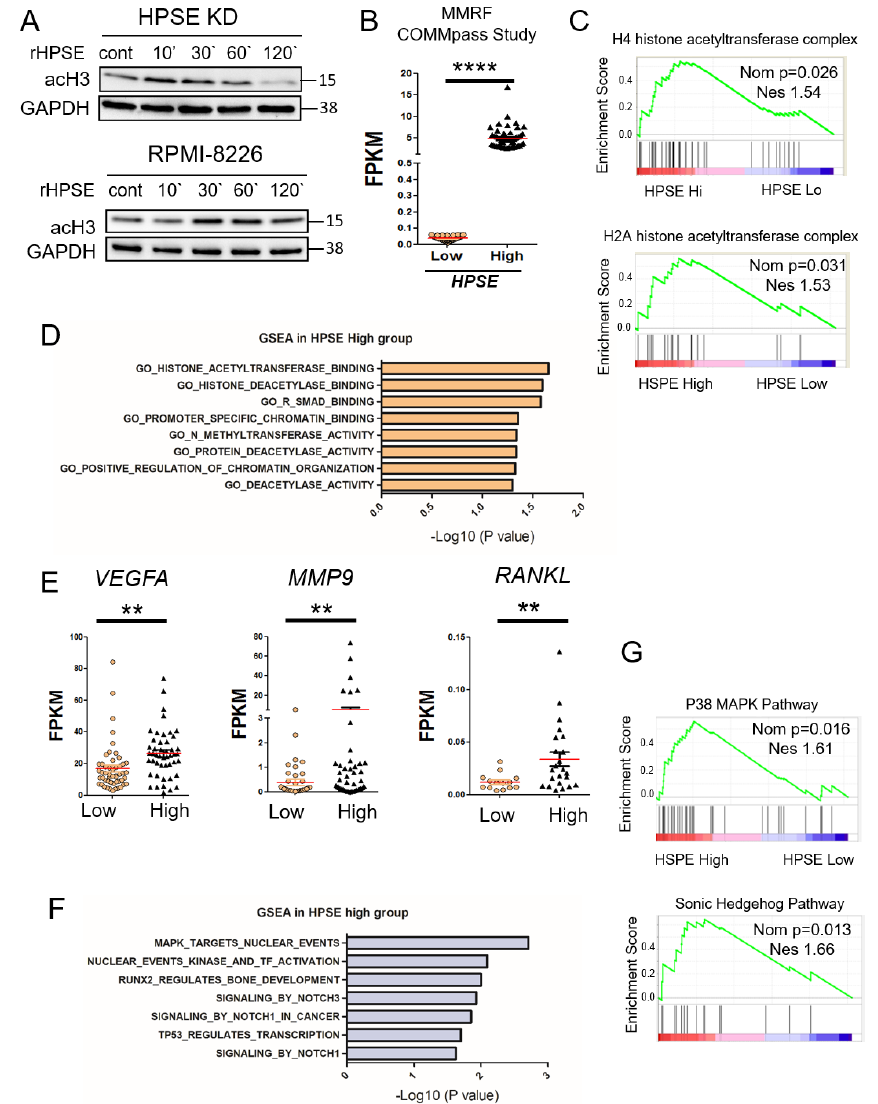
Figure 2. Heparanase stimulates histone acetylation and upregulation of genes that promote an aggressive tumor phenotype. ( A ) CAG HPSE KD and RPMI-8226 cells were incubated with 1 µg/mL of rHPSE for the indicated time and acetyl-histone 3 expression assessed by Western blot. ( B ) Data from the MMRF CoMMpass study were mined to assess the level of heparanase expression in a set of patients with >50% CD138+ cells. Results were plotted for patients with low heparanase (HPSE-low) expression (FPKM < 0.1; n = 50) and high heparanase (HPSE-high) expression (FPKM > 2, n = 50). The red bars represent the mean expression level of each group; **** p < 0.0001 by one-tailed, impaired t -test. ( C ) Gene set enrichment analysis (GSEA) was performed on the HPSE-high and HPSE-low patient groups, revealing enhanced acetyl-transferase signatures for H4 and H2A in the